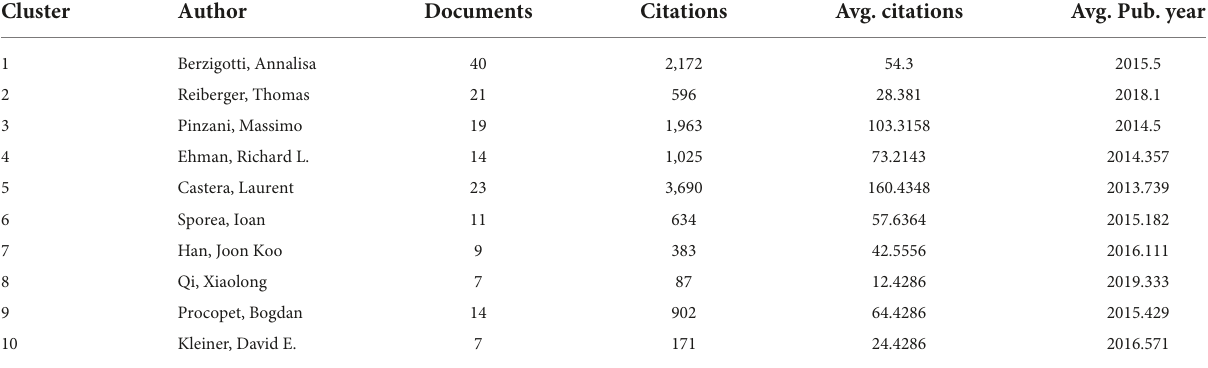
TABLE 5 The highest-yield author of each